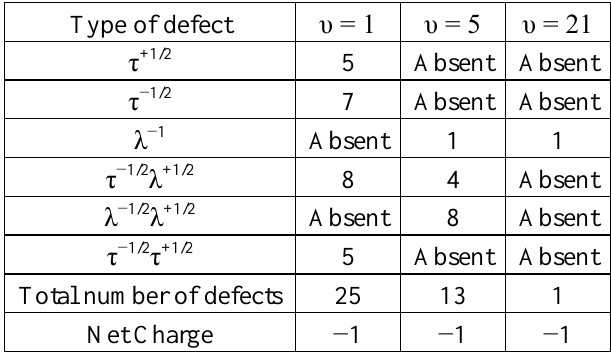
and chirality q z